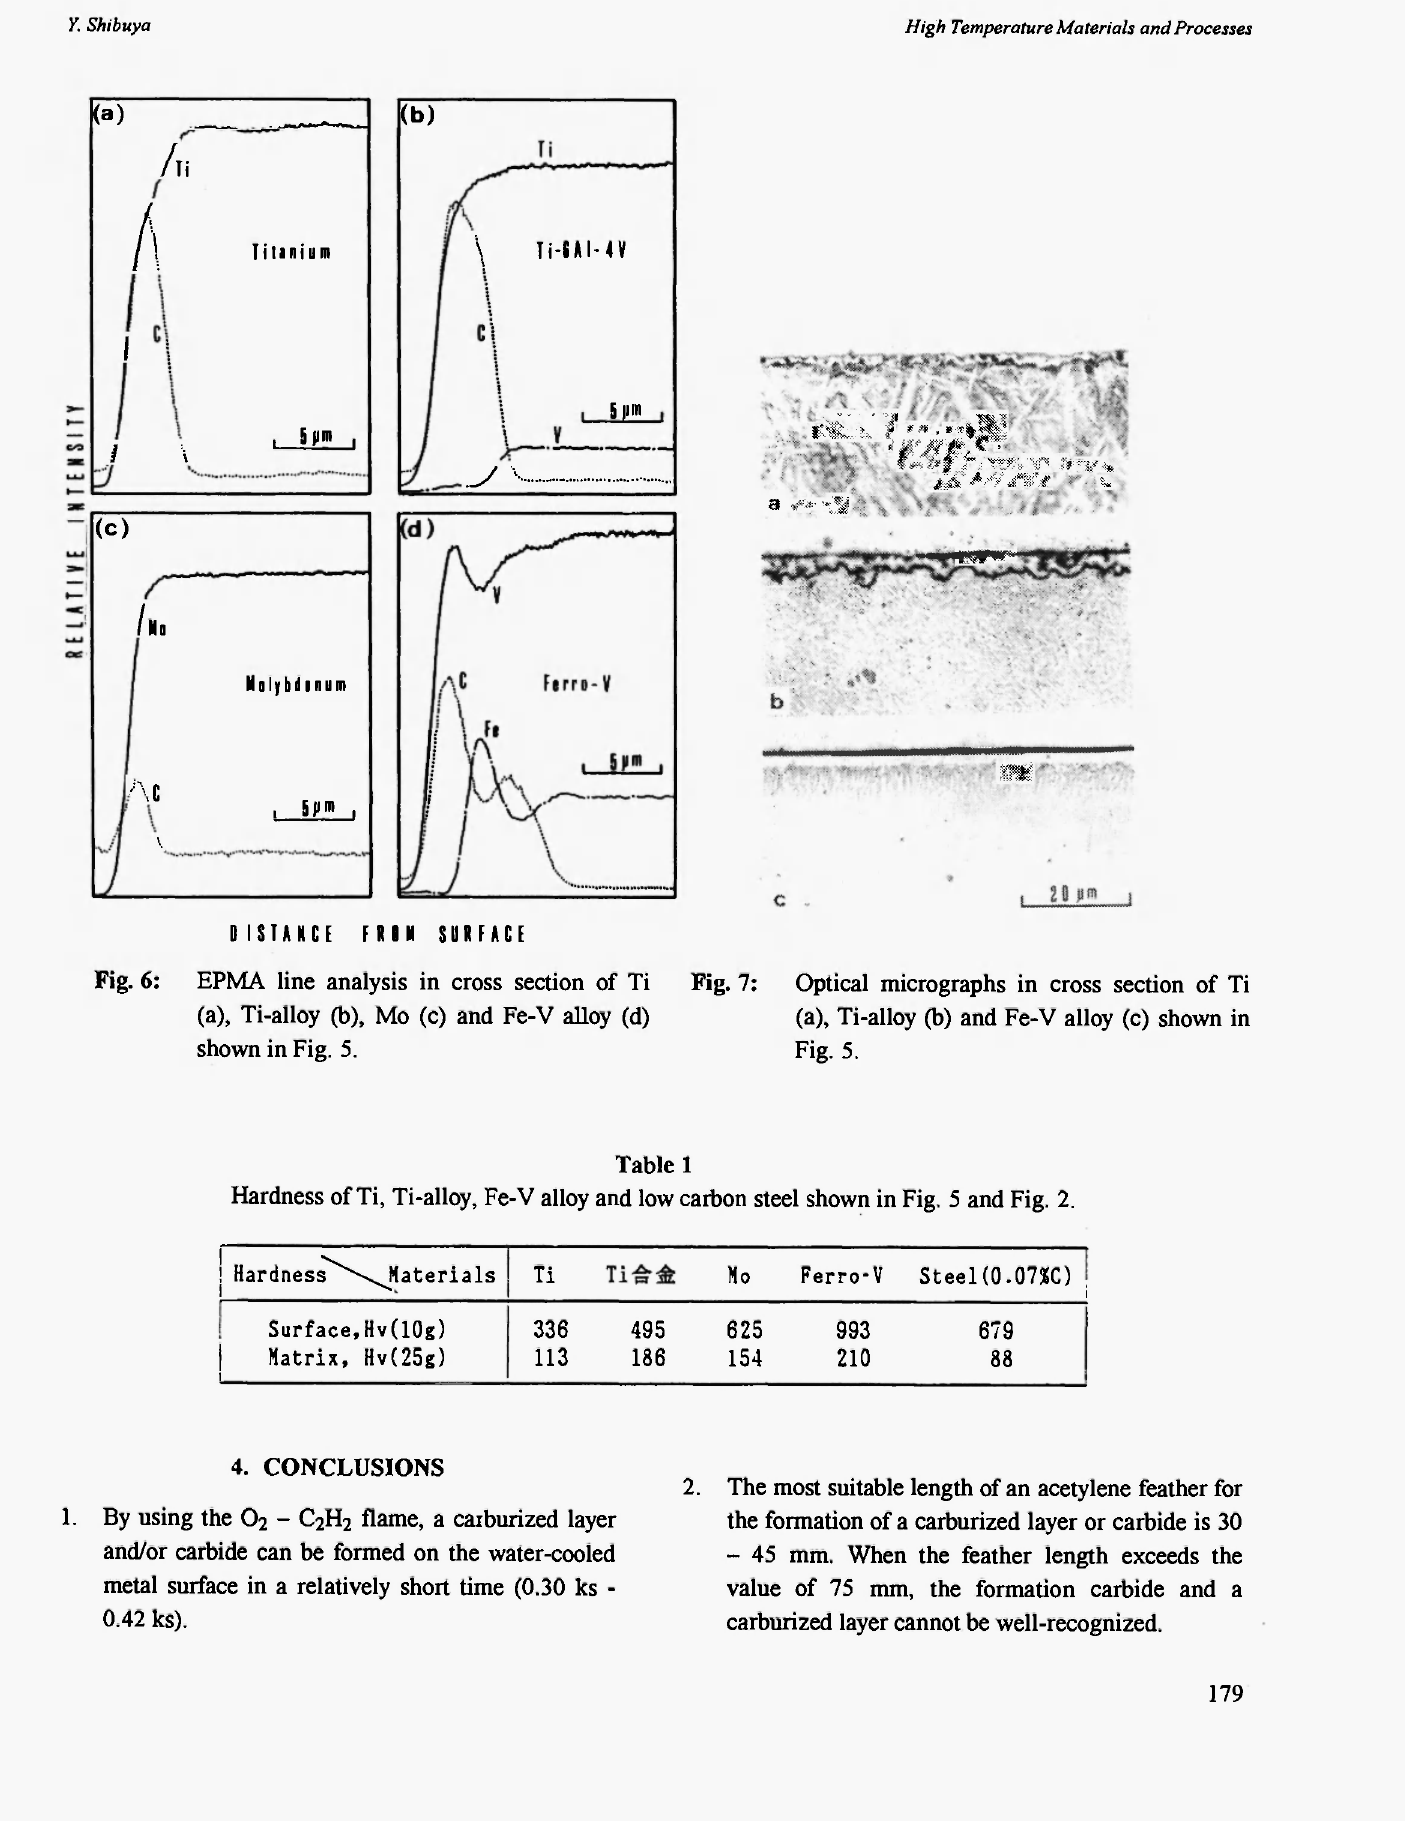
(a), Ti-alloy (b), Mo (c) and Fe-V alloy (d) (a), Ti-alloy (b) and Fe-V alloy (c) shown in shown in Fig. 5.